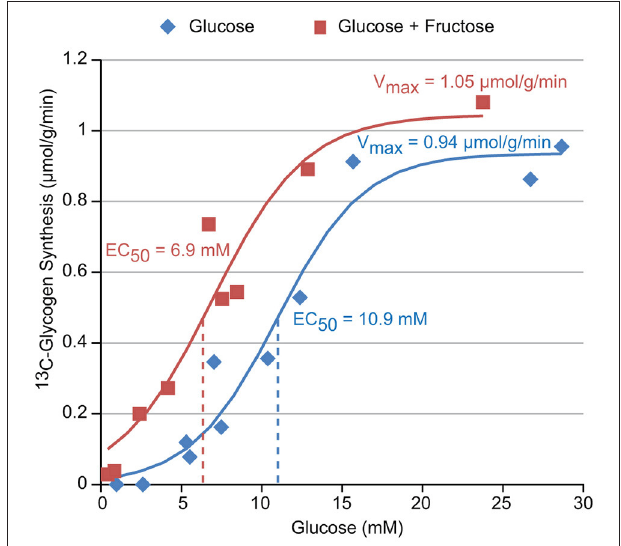
FIGURE 4 | The glucose dependence of glycogen synthesis in perfused liver with and without 1 mM fructose in the perfusate.